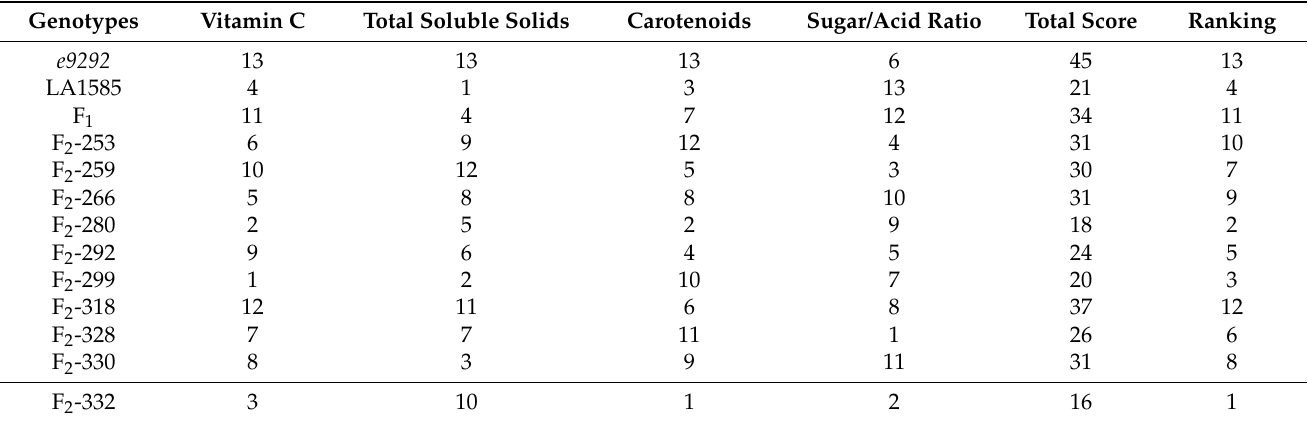
Table 3. Quality ranking of tomatoes with different genetic